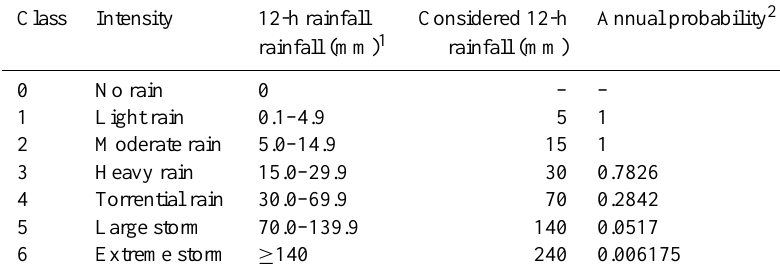
Table 1. Classification of six rainfall scenarios.